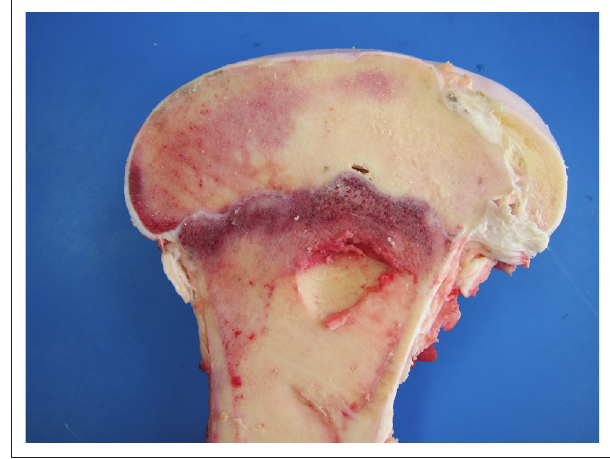
FIGURE 5: Abnormal trabecular pattern of the growth plate was noted in young animals.